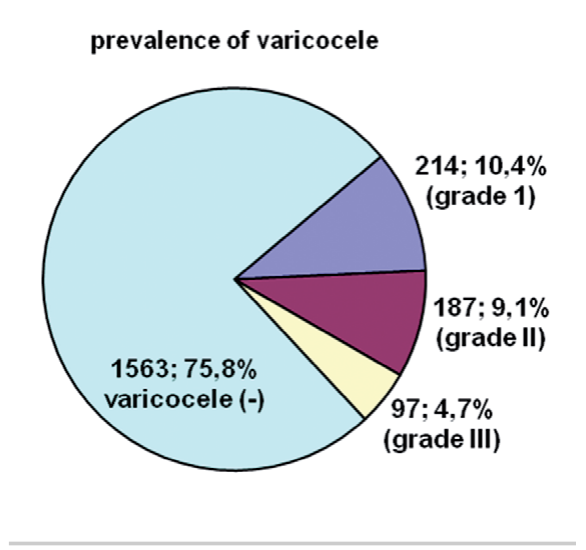
Figure 1 - Prevalences of varicocele grades in 2061 young men in